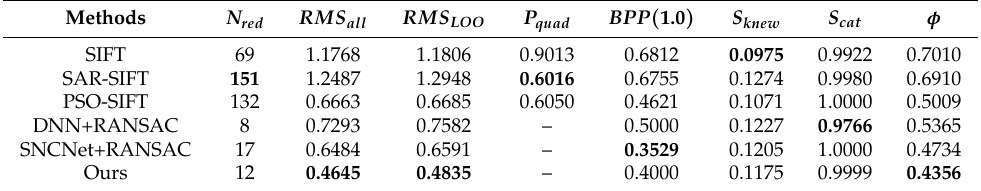
Table 3. The quantitative comparison among six methods on Yamba images.